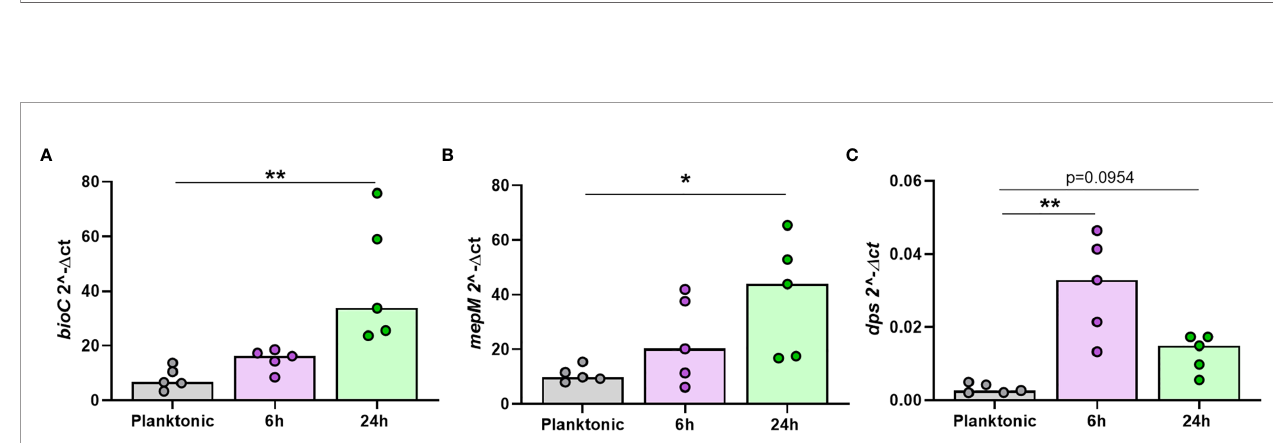
FIGURE 6 | Modulation of NTHi processes during adaption to intracellular persistence. (A) The stacked bar chart highlights the main processes that the 108 NTHi DEGs are involved in. The process with the highest number of genes was metabolic processes (29), followed by regulation of gene expression (23), stress responses (8), virulence (5), replication (5) and protein regulation (2). The remaining genes (36) were uncharacterised (hypothetical, novel genes or sRNA). (B) Genes involved in bacterial metabolism were assigned to speci fi c alternate metabolic pathways. Red = upregulated, blue = downregulated. (C) KEGG pathway analysis identi fi ed enrichment of KEGG pathways during intracellular persistence, ordered by enrichment signi fi cance (FDR). (D) KEGG pathway analysis identi fi ed the most signi fi cantly enriched pathway was ‘ Ribosome ’ . Exploration of ribosomal protein gene expression identi fi ed global downregulation of NTHi ribosomal protein genes during infection. Bar chart shows log 2 FC values of the 46 ribosomal protein genes detected in the NTHi data set. Dotted line indicates log 2 FC1 cut off, with asterisk indicating genes (37) that were determined to be signi fi cantly differentially expressed at FDR p < 0.05.